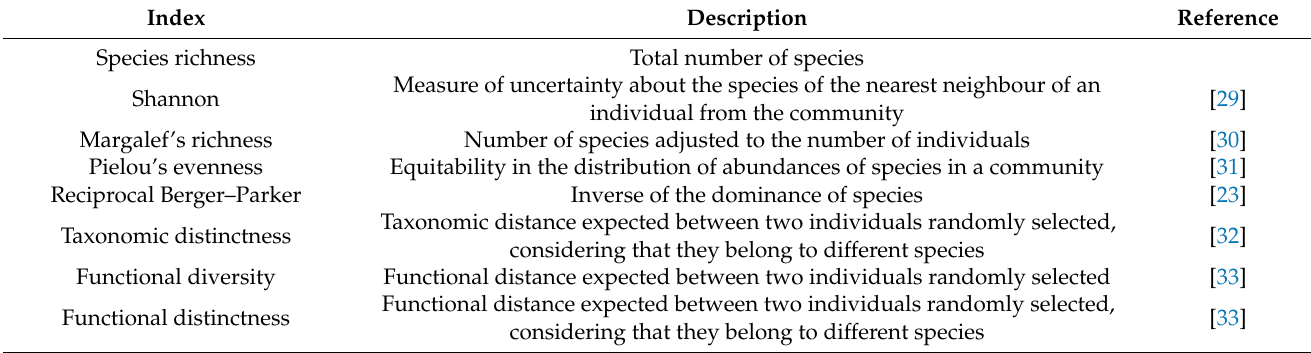
Table 3. Diversity indices which have been compared to the N 90 in previous studies